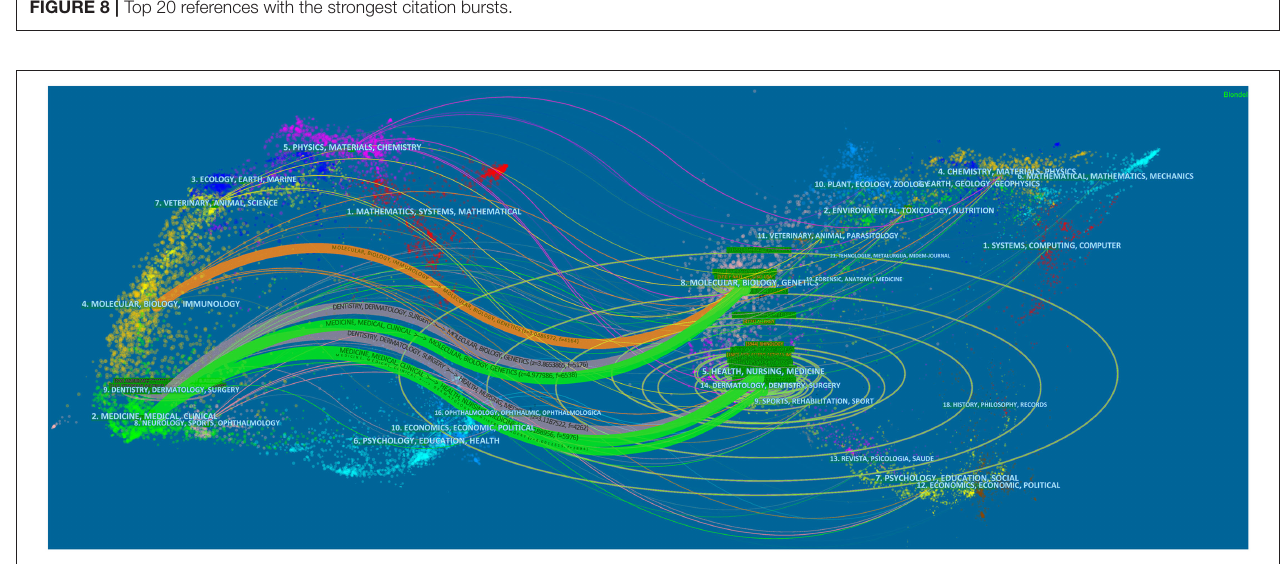
FIGURE 9 | The dual-map overlay of journals on